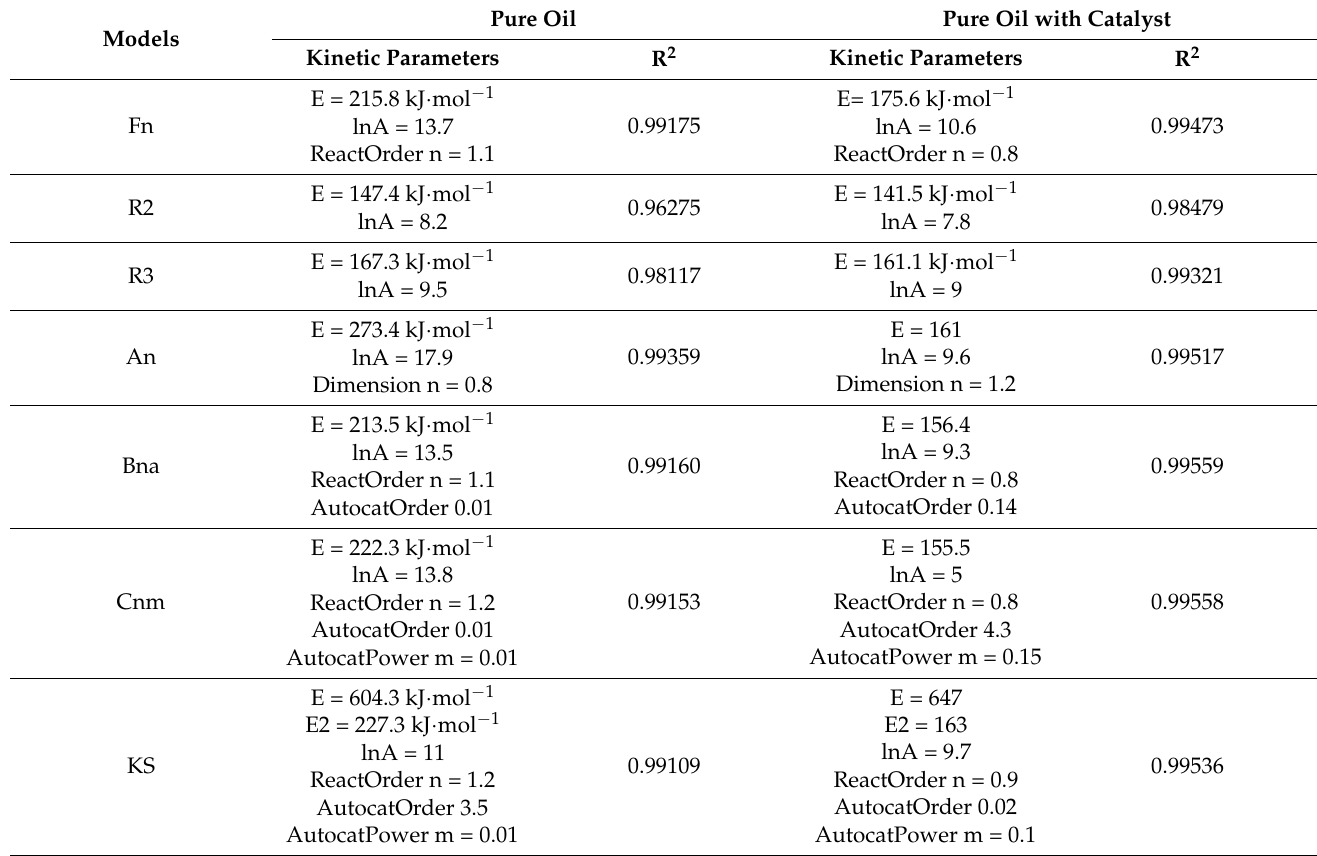
Table 8. Kinetic parameters of extra-heavy oil pyrolysis process obtained from the model-based